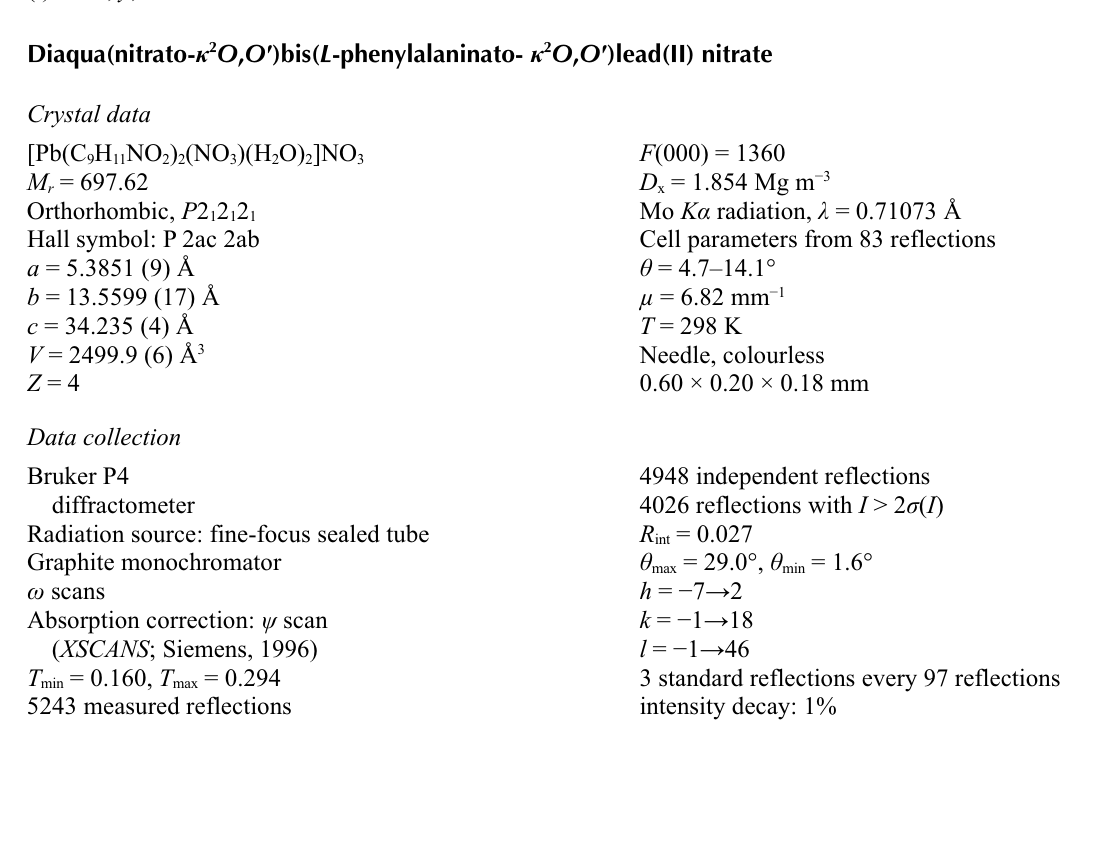
Figure 2 Two symmetry-related molecules in the crystal structure, omitting H atoms and non-coordinated nitrate ions. The blue plane is calculated using atoms Pb1/O1/O3/O4/O21 (spheres of arbitrary radii) and corresponds to the equatorial plane defining the hemidirected ligand arrangement. The short inter-cation contact is shown as a dashed line. Symmetry code: ( i ) 1 + x , y , z